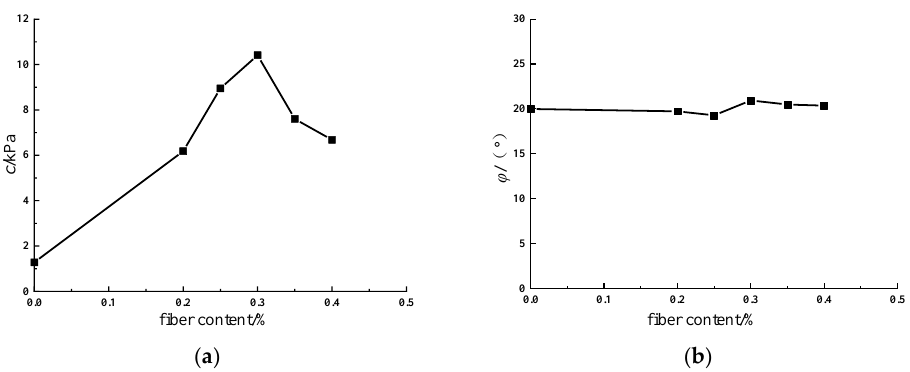
Figure 8. Variation in shear strength index with fiber content. ( a ) influence of fiber content on cohesion; ( b ) influence of fiber content on internal friction angle.